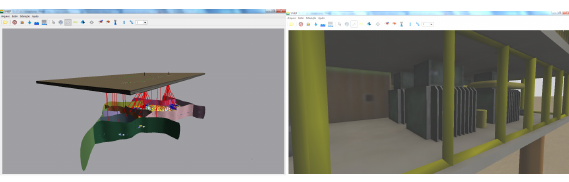
Figure 2. SiVIEP: visualization of an oil enterprise. In the first image, a complete oil field can be seen. In the second image, the camera reaches the scale of a platform and the interior of the platform can be